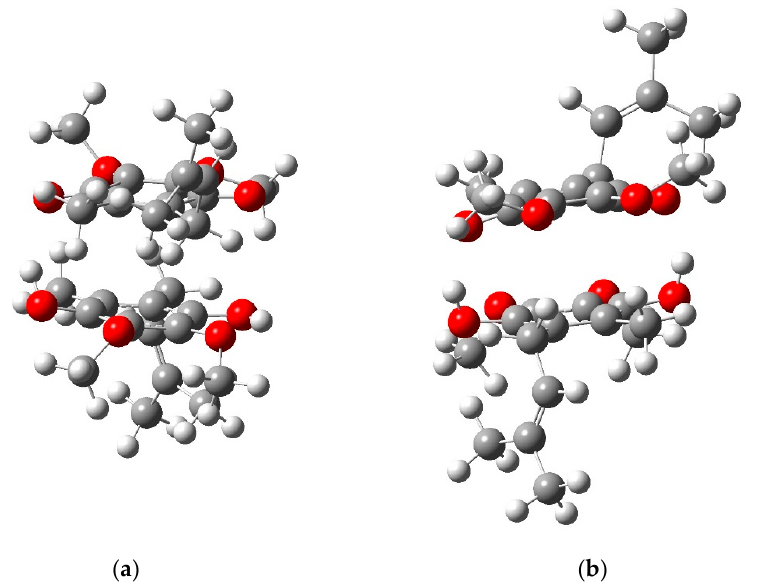
was an exothermic reaction ∆ r E = 106 kJ mol − 1 . The two molecules can form one or two hydrogen bonds. The two most stable geometries are represented in Figure 8.